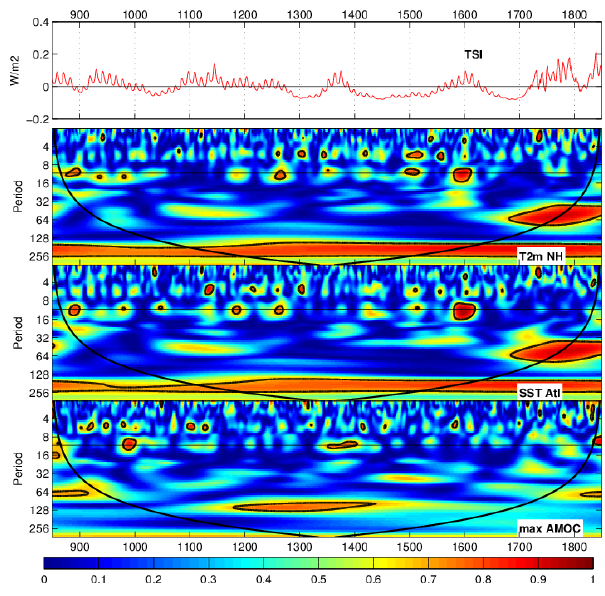
Fig. 4. Time series of the solar forcing (top) and cross-wavelet co- herence spectrum of the temperature time series in Fig. 2 (bottom three panels). The thick contours enclose regions of greater than 95% confidence and the thin lines indicate the limit of the cone of influence. The horizontal line indicates the 11 year